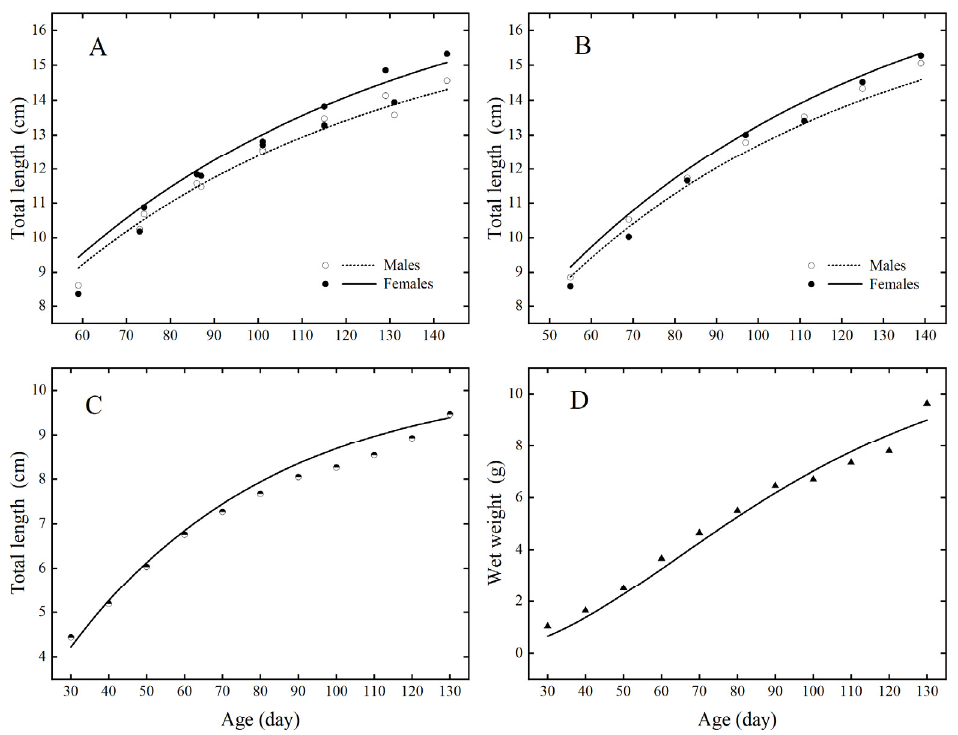
Figure 2. Comparison of model predictions and observations of total length and weight in Guzhenkou Bay ( A ), Laoshan Bay ( B ) and an intensive aquaculture pond Hainan Province, China ( C , D ). The lines indicate model predictions of growth. The circles and triangles indicate observations of total length and wet weight growth, respectively. In ( A , B ), solid lines and symbols are predictions for females, and dashed lines and open symbols are predictions for males. The observations reflect the mean growth of the species in each environment.